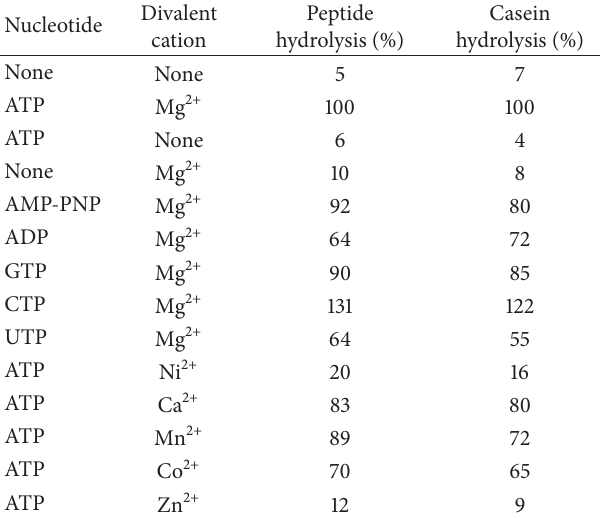
Table 1: Relative cleavage activities of Lon-like-Ms in the presence of different nucleotides or divalent cations.